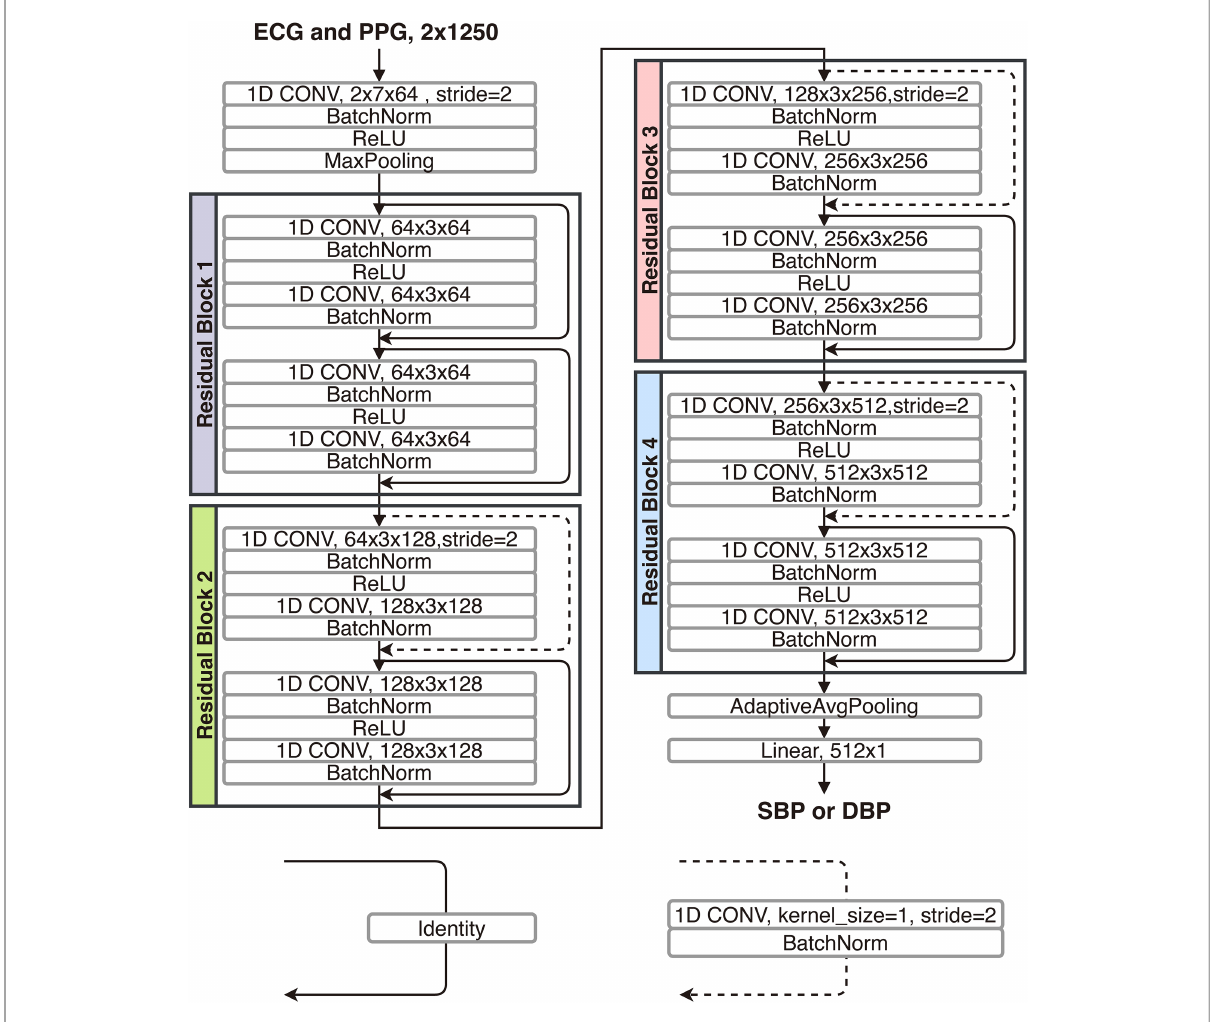
FIGURE 4 Structure of the 1D-modi fi ed ResNet-18 used for comparing calibration-based and calibration-free model testing